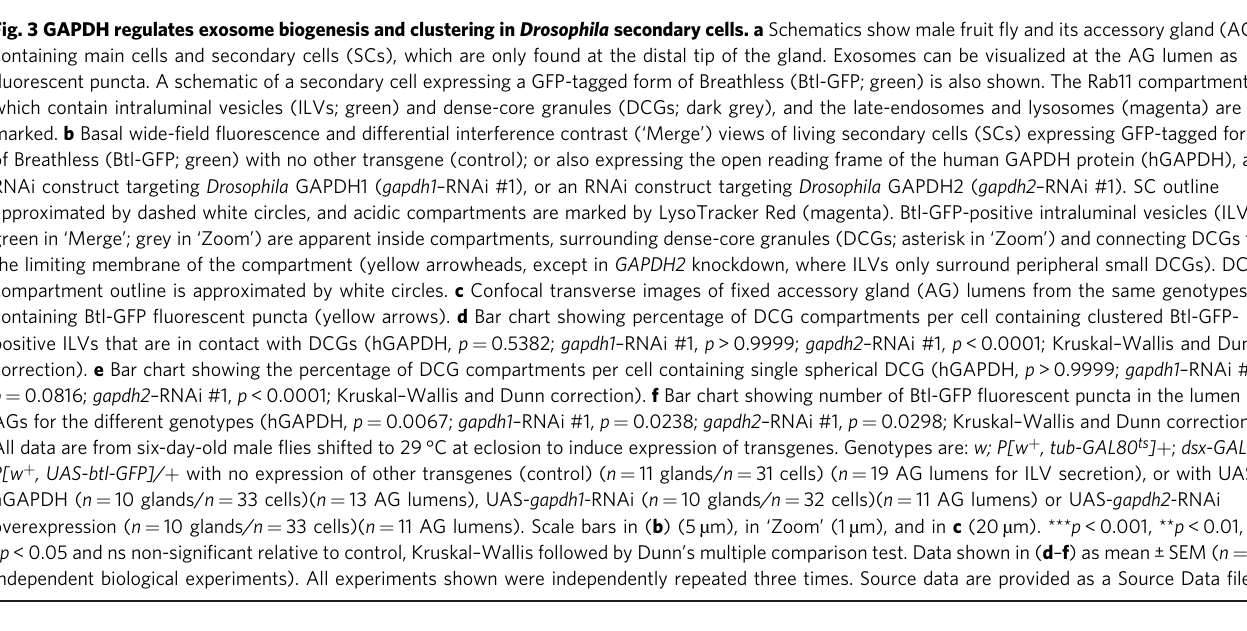
Fig. 3 GAPDH regulates exosome biogenesis and clustering in Drosophila secondary cells. a Schematics show male fruit fl y and its accessory gland (AG) containing main cells and secondary cells (SCs), which are only found at the distal tip of the gland. Exosomes can be visualized at the AG lumen as fl uorescent puncta. A schematic of a secondary cell expressing a GFP-tagged form of Breathless (Btl-GFP; green) is also shown. The Rab11 compartments, which contain intraluminal vesicles (ILVs; green) and dense-core granules (DCGs; dark grey), and the late-endosomes and lysosomes (magenta) are marked. b Basal wide- fi eld fl uorescence and differential interference contrast ( ‘ Merge ’ ) views of living secondary cells (SCs) expressing GFP-tagged form of Breathless (Btl-GFP; green) with no other transgene (control); or also expressing the open reading frame of the human GAPDH protein (hGAPDH), an RNAi construct targeting Drosophila GAPDH1 ( gapdh1 – RNAi #1), or an RNAi construct targeting Drosophila GAPDH2 ( gapdh2 – RNAi #1). SC outline approximated by dashed white circles, and acidic compartments are marked by LysoTracker Red (magenta). Btl-GFP-positive intraluminal vesicles (ILVs; green in ‘ Merge ’ ; grey in ‘ Zoom ’ ) are apparent inside compartments, surrounding dense-core granules (DCGs; asterisk in ‘ Zoom ’ ) and connecting DCGs to the limiting membrane of the compartment (yellow arrowheads, except in GAPDH2 knockdown, where ILVs only surround peripheral small DCGs). DCG compartment outline is approximated by white circles. c Confocal transverse images of fi xed accessory gland (AG) lumens from the same genotypes, containing Btl-GFP fl uorescent puncta (yellow arrows). d Bar chart showing percentage of DCG compartments per cell containing clustered Btl-GFP- positive ILVs that are in contact with DCGs (hGAPDH, p = 0.5382; gapdh1 – RNAi #1, p > 0.9999; gapdh2 – RNAi #1, p < 0.0001; Kruskal – Wallis and Dunn correction). e Bar chart showing the percentage of DCG compartments per cell containing single spherical DCG (hGAPDH, p > 0.9999; gapdh1 – RNAi #1, p = 0.0816; gapdh2 – RNAi #1, p < 0.0001; Kruskal – Wallis and Dunn correction). f Bar chart showing number of Btl-GFP fl uorescent puncta in the lumen of AGs for the different genotypes (hGAPDH, p = 0.0067; gapdh1 – RNAi #1, p = 0.0238; gapdh2 – RNAi #1, p = 0.0298; Kruskal – Wallis and Dunn correction). All data are from six-day-old male fl ies shifted to 29 °C at eclosion to induce expression of transgenes. Genotypes are: w; P[w + , tub-GAL80 ts ] + ; dsx-GAL4, P[w + , UAS-btl-GFP]/ + with no expression of other transgenes (control) ( n = 11 glands/ n = 31 cells) ( n = 19 AG lumens for ILV secretion), or with UAS- hGAPDH ( n = 10 glands/ n = 33 cells)( n = 13 AG lumens), UAS- gapdh1 -RNAi ( n = 10 glands /n = 32 cells)( n = 11 AG lumens) or UAS- gapdh2 -RNAi overexpression ( n = 10 glands /n = 33 cells)( n = 11 AG lumens). Scale bars in ( b ) (5 µ m), in ‘ Zoom ’ (1 µ m), and in c (20 µ m). *** p < 0.001, ** p < 0.01, * p < 0.05 and ns non-signi fi cant relative to control, Kruskal – Wallis followed by Dunn ’ s multiple comparison test. Data shown in ( d – f ) as mean ± SEM ( n = 3 independent biological experiments). All experiments shown were independently repeated three times. Source data are provided as a Source Data fi